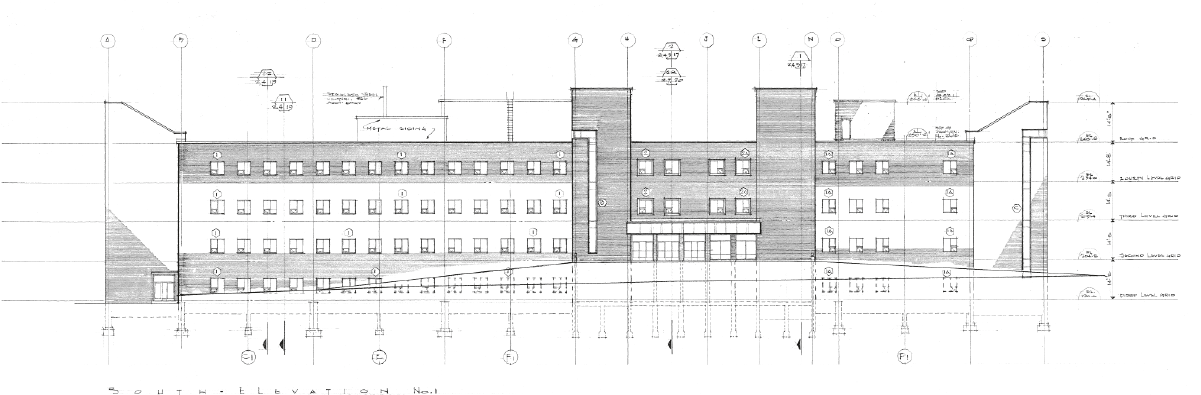
Figure 5: South elevation of the building.